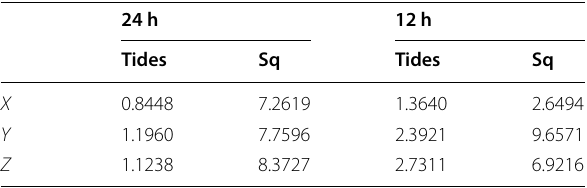
Same as Table 4